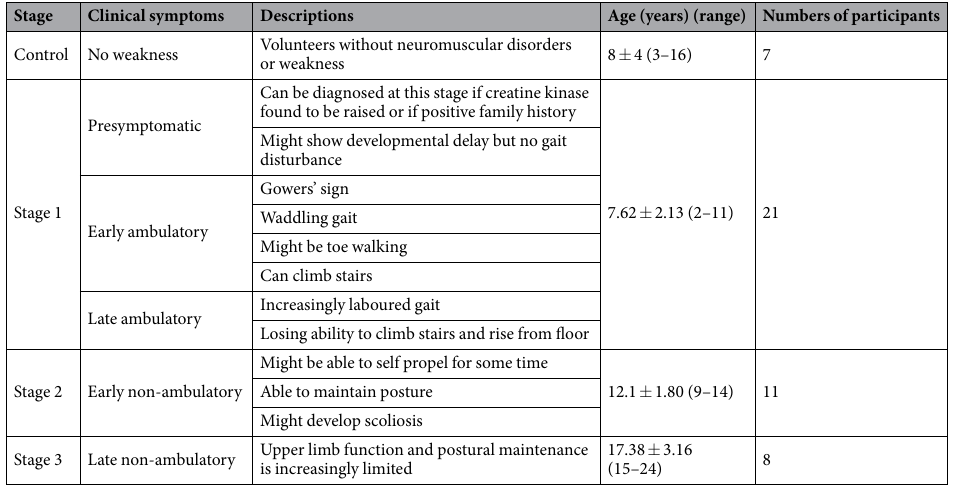
Table 1. The demographic data and DMD stage